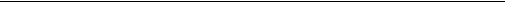
Fig. 4 Neutron scattering in parallel fi eld geometry at 1.6 K. a Rocking curves are collected by rotating the sample, fi eld and vortices together through the Bragg condition. Neutron counts are summed over an area on the 2D multidetector encompassing the Bragg spot (red sector in Fig. 2a). Error bars are determined by Poisson statistics. Solid line is a Gaussian fi t, with W ω denoting the measured rocking curve width. b Field dependence, at T = 1.6 K, of the scattered neutron intensity I integrated over the rocking curve. Vortex ensembles are prepared by fi eld-cooling, i.e. by cooling in the desired fi eld from the normal state. Dotted line is a guide to the eye illustrating the form expected if vortices were arranged in a perfect 2D lattice. A steeper descent arises from the quasi-long-range order of the Bragg glass picture and scales to the data well (solid line) up to 0.26 T, whereupon I decays rapidly. Note that I vanishes much before the peak effect B pp . c W ω probes correlations along the vortices in the parallel fi eld geometry (Fig. 2a). The dominant contribution to the instrument resolution is the angular spread a of the incoming beam, illustrated by the dashed line. a = 0.077° corresponds to a maximum resolvable correlation length s = 2.35/( ga ) = 240 a 0 . d Radial width W r of the Bragg spot on the 2D